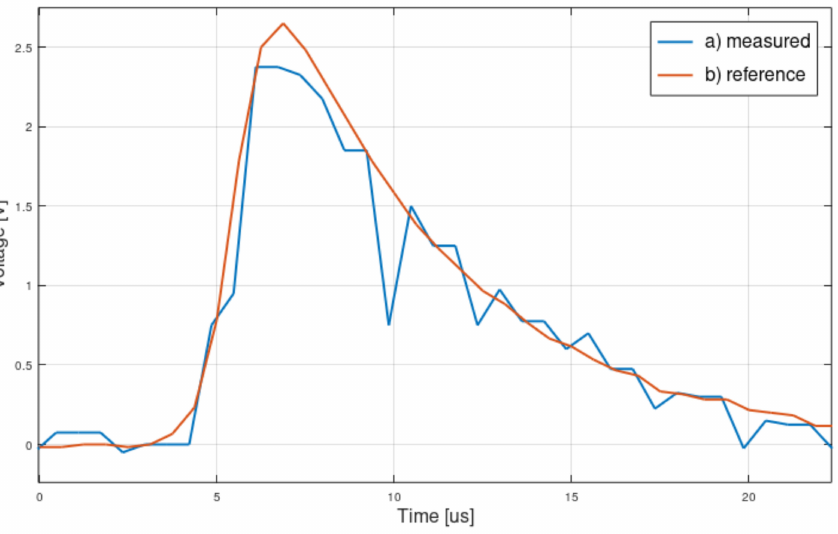
Figure 5. The measured waveform of the shock pulse along with the reference